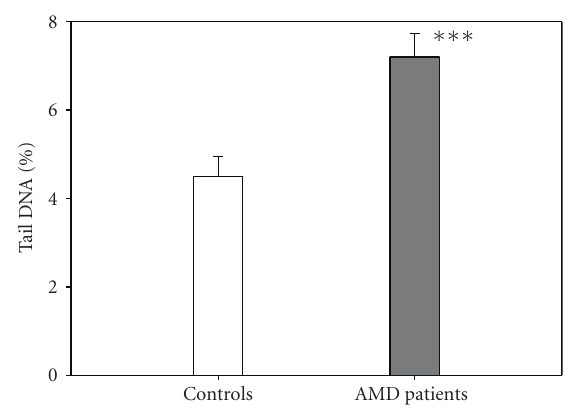
Figure 1: Endogenous DNA damage (DNA strand breaks and alkali-labile sites), measured as the mean comet percentage tail DNA in the alkaline comet assay in human peripheral blood lymphocytes of healthy controls (white bar) and AMD patients (grey bar). Thirty individuals were analysed in either group. The number of cells scored for each individual was 100. The results displayed are the mean of three independent experiments ± S.E.M. ∗∗∗ P < .